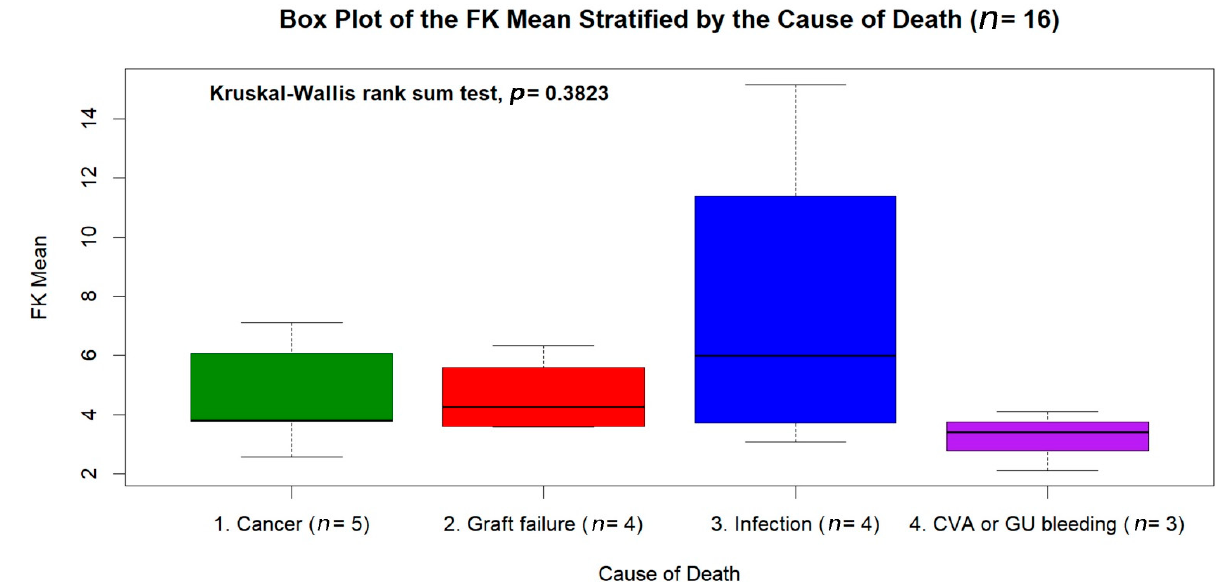
Figure 2. The box plot of tacrolimus mean trough level stratified by the etiology and cause of death among the 16 dead patients. There was no statistical difference of tacrolimus level between the different causes of death ( p = 0.3823).